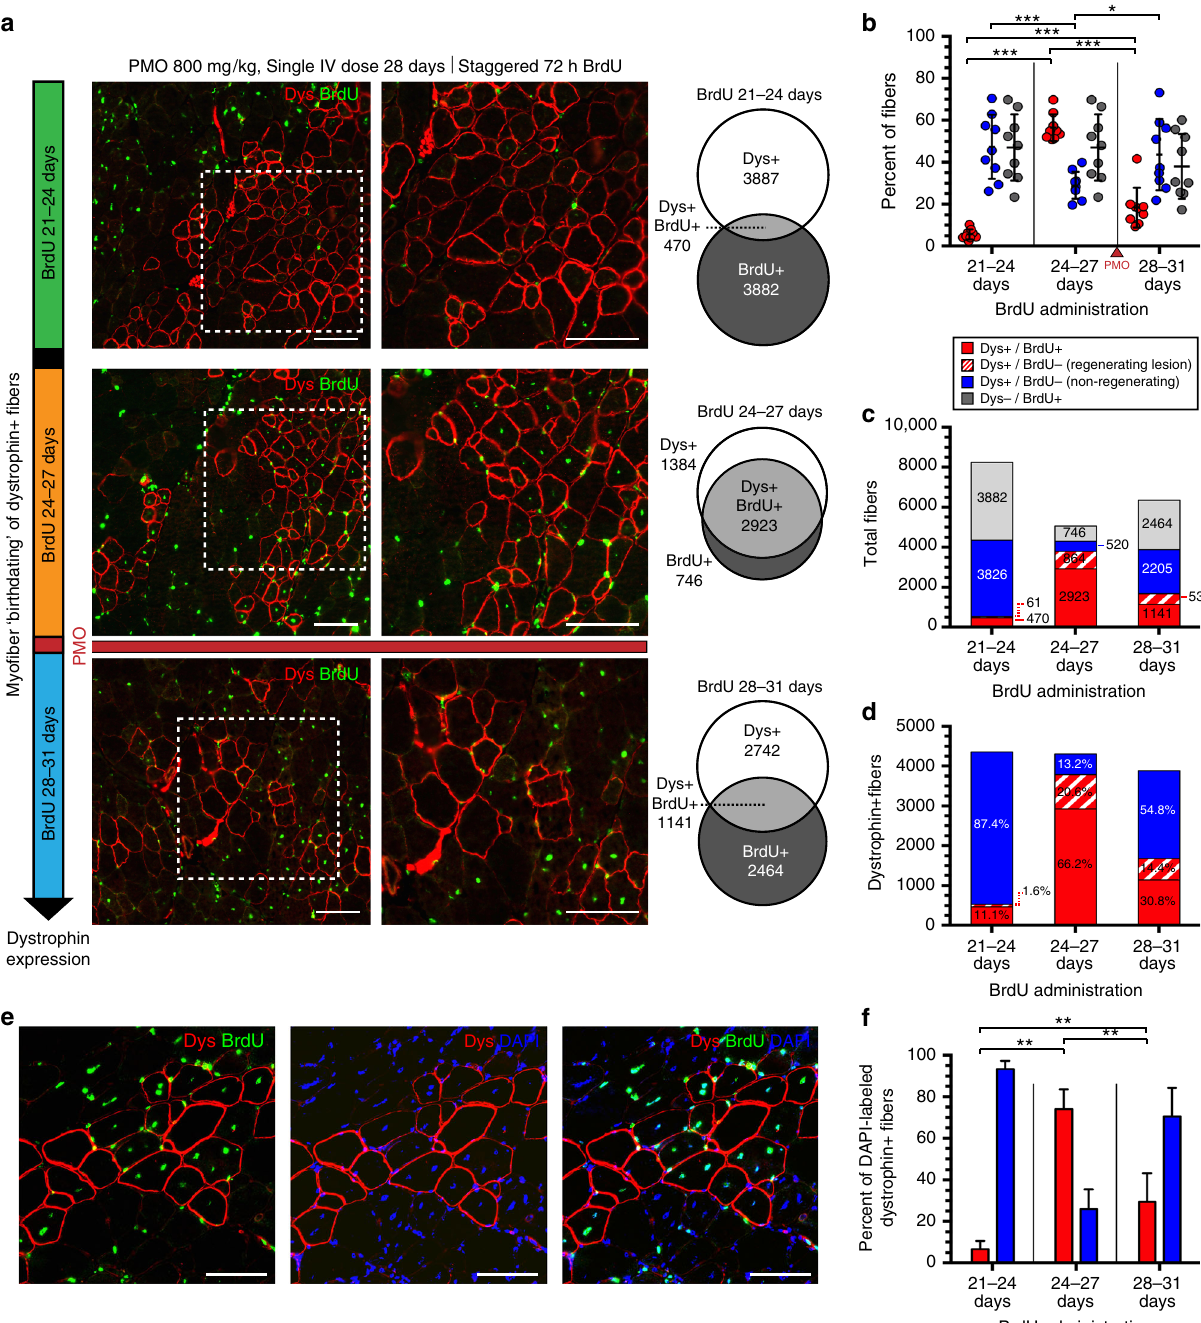
Fig. 2 Systemic PMO delivery targets dystrophin expression to spontaneously regenerating mdx myo fi bers. a Dystrophin expression in 6 week mdx mice (i.e., tricep, gastrocnemius, and quadriceps) after single IV dose of PMO (800 mg/kg, n = 3). PMO injected at day 28 together with staggered pulses of overlap between dystrophin expression (Dys +ve ) and myo fi ber regeneration (BrdU +ve ). b Quanti fi cation of Dys +ve /BrdU +ve , Dys +ve /BrdU − ve , and Dys − ve / BrdU +ve myo fi bers for each BrdU cohort shown as a percentage of labeled fi bers. Data represented as scatter plot with SD; n = 3 mdx mice per BrdU cohort. c Quanti fi cation of total fi bers characterized as Dys +ve /BrdU +ve ( red ), Dys +ve /BrdU − ve within a regenerating lesion ( dashed red ), Dys +ve /BrdU − ve isolated revertants ( blue ), or Dys − ve /BrdU +ve ( gray ). d Quanti fi cation of BrdU co-localization in dystrophin +ve fi bers; Dys +ve /BrdU +ve ( red ), Dys +ve /BrdU − ve within a regenerating lesion ( dashed red ), Dys +ve /BrdU − ve ( blue ) ( n = 3). e BrdU-DAPI co-staining procedure to con fi rm BrdU speci fi city and assess prevalence of central myonuclei per myo fi ber within a given cross-section. f Quanti fi cation of BrdU-labeling for centrally nucleated (DAPI +ve ), dystrophin +ve myo fi bers. Scale bars represent 100 μ m. Statistical analysis performed by Mann – Whitney nonparametric test; *** p < 0.001, ** p < 0.01, * p <